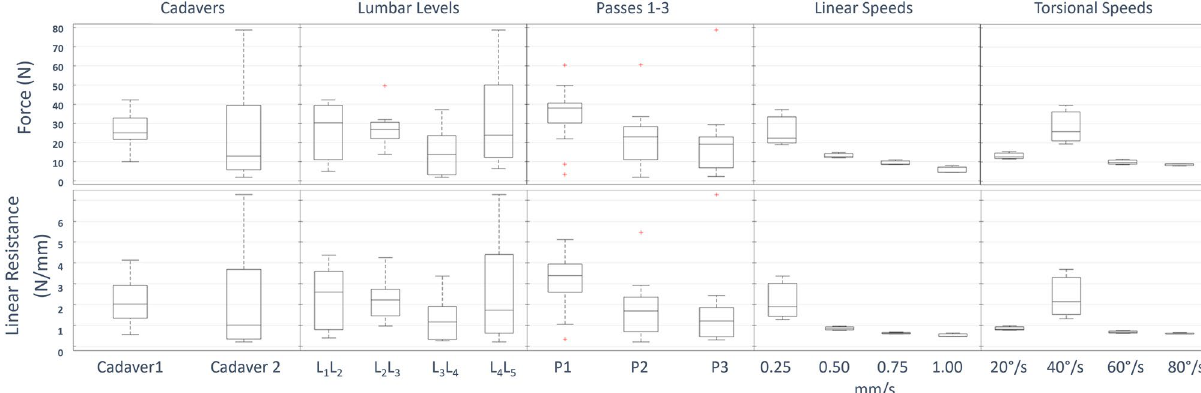
Figure 3. Force peak and linear resistance comparisons.